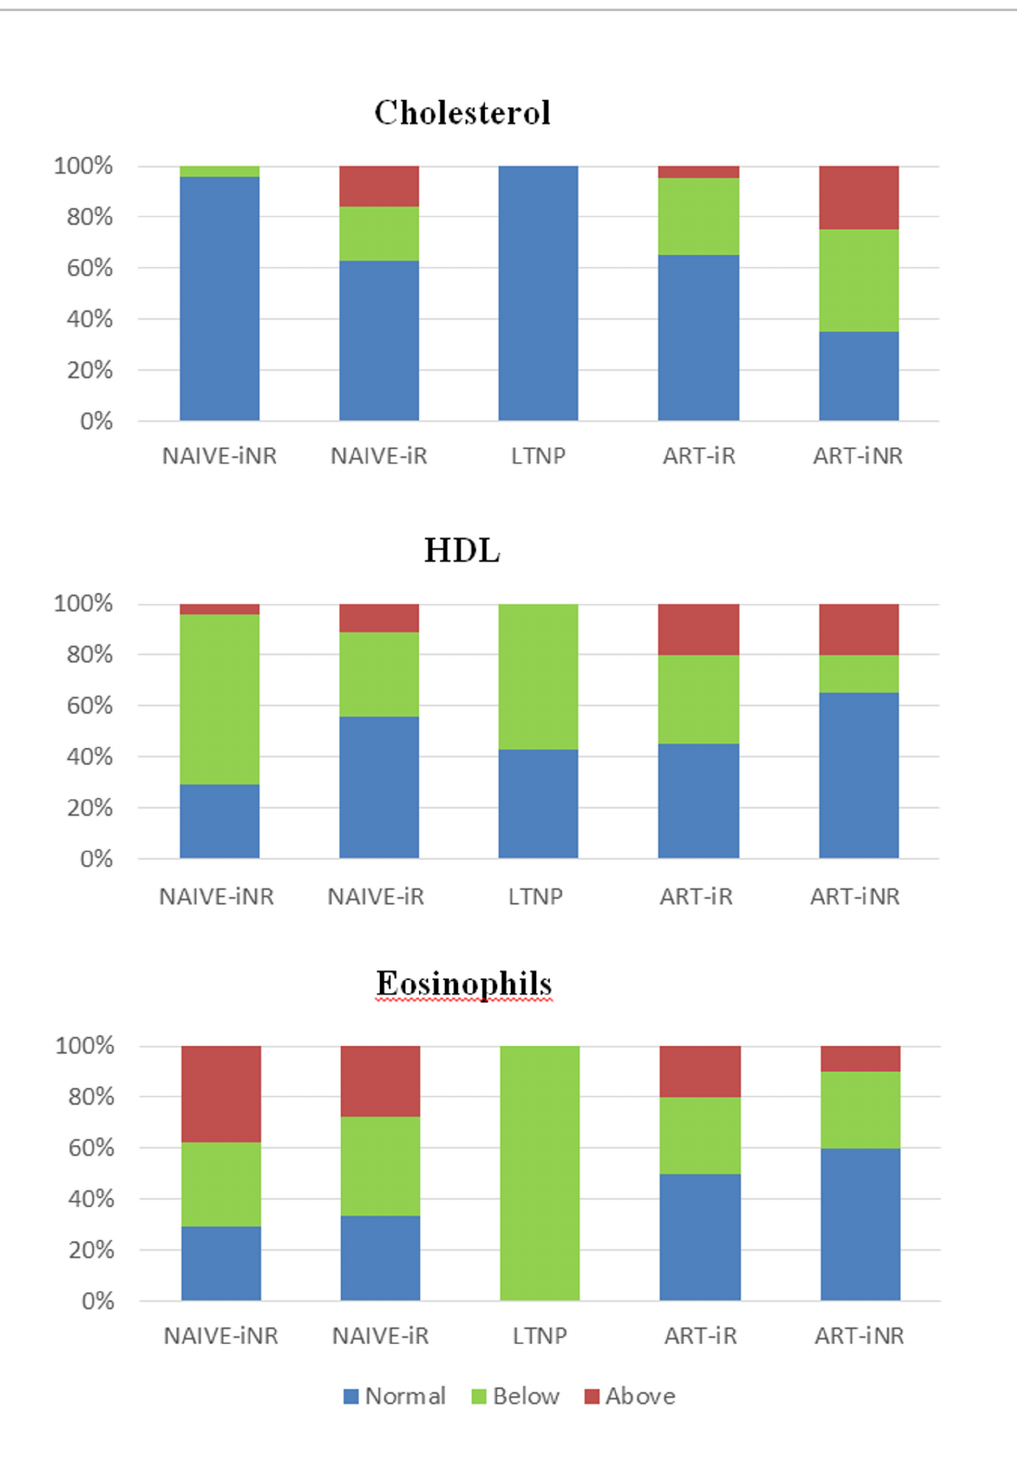
FIGURE 3 - Difference in the Proportions of Abnormal Cholesterol, HDL and Eosinophils in all HIV-infected groups. Difference in the Proportions (p<0,05). Normal results in blue; Low values in green; High values in red; Very high values in brown. ART: antiretroviral therapy; Naïve: ART-naïve; iR: immunological responder; iNR: immunological non-responder; LTNP: long-term